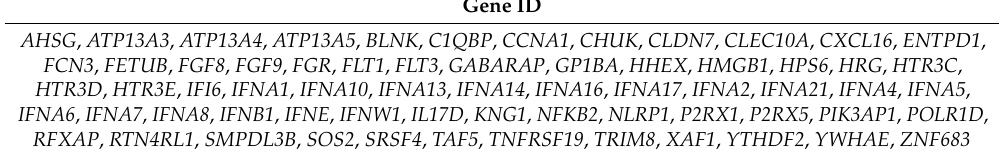
Figure 3. Matrix layout for all 65 genes across 35 functional categories (association calculated by DAVID), sorted by size. Dark circles in the matrix indicate functional categories with genes that are part of the intersecting groups, that is, are associated with each category of the set. The bar plot above the matrix depicts the number of shared genes, while the horizontal bar plot on the left reflects the number of genes within each group. Blue and red colored bars indicate the respective aberration. Table 9. List of genes within CNAs associated with significantly enriched functional categories as calculated using DAVID computational strategy (Bonferroni and BH adjusted p -value threshold set to α = 0.05).